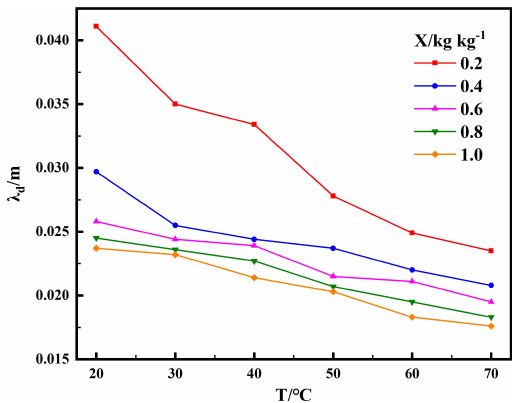
Figure 4: Microwave length in paracetamol at temperatures between 20 and 70 ∘ C and in the moisture contents range of 0.2–1 kg kg −1 (2450